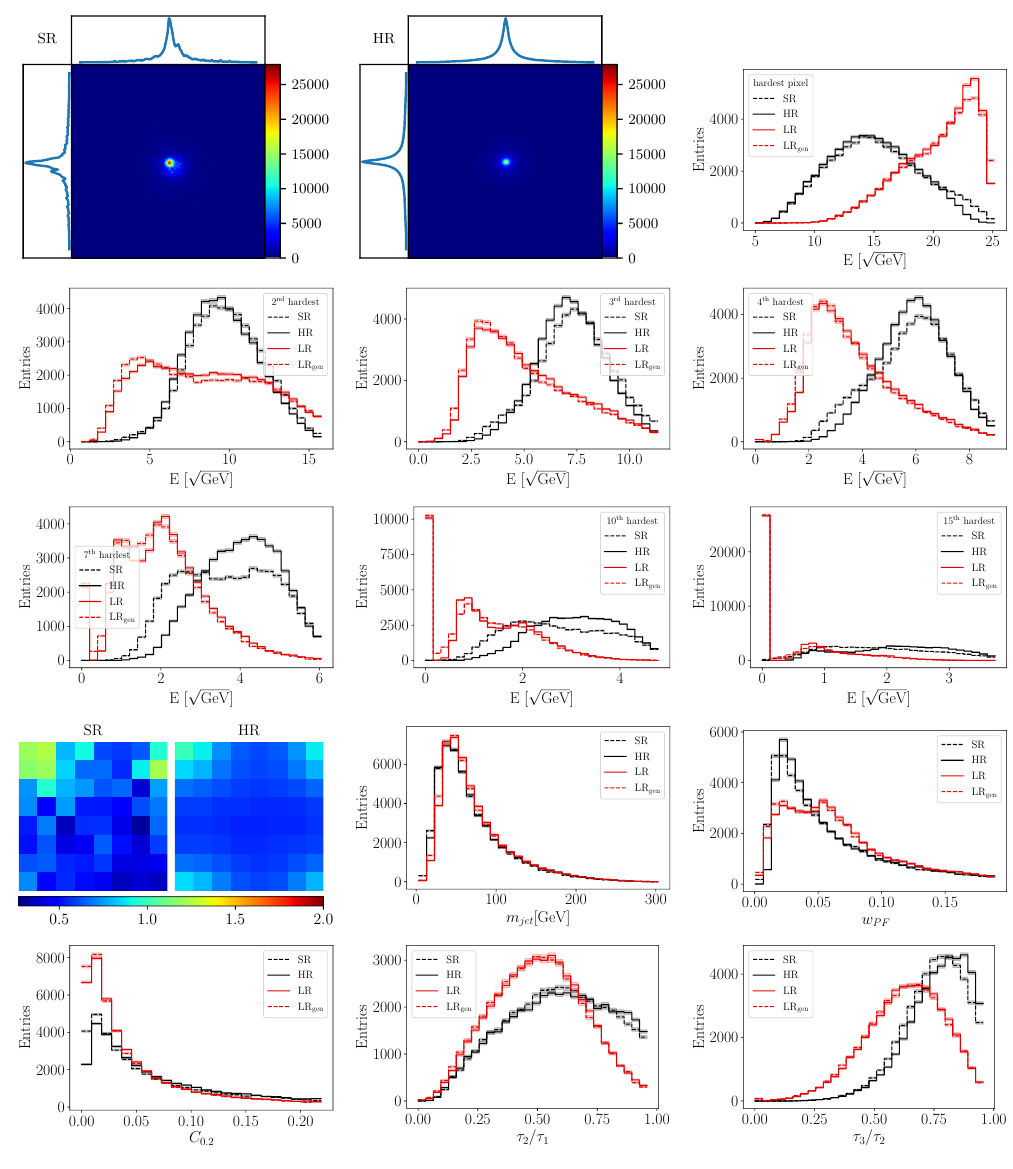
Figure 4: Demonstration of the performance of a network trained on QCD-jets and applied to QCD-jets. Top left are averages of the HR and SR images, followed by distributions of the square-root of the energy of leading pixels, sub-leading, etc. Also shown are average ( f × f )-patches for the SR and the HR images, and distributions of high-level jet observables, see text for definitions. The zero-bin in energy collects jets with too few